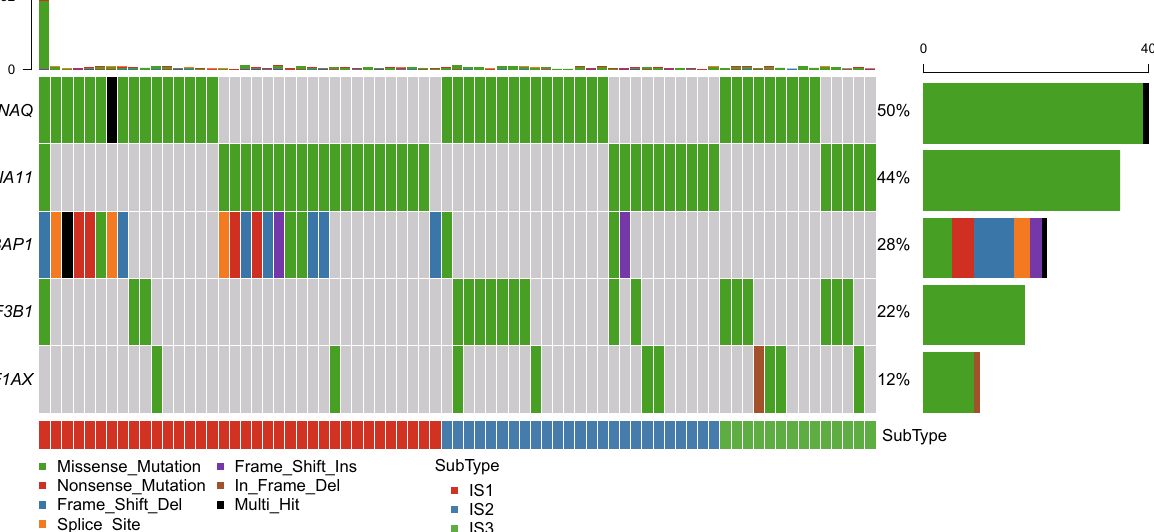
Figure 2. Genetic mutations in different ISs. ( A ) TMB differences between the three ISs. ( B ) Difference analysis was used to compare the number of gene mutations in the three IS samples. ( C ) Mutation characteristics of the top5 significantly mutated genes in each IS samples. *P < 0.05, **P < 0.01. NS: not